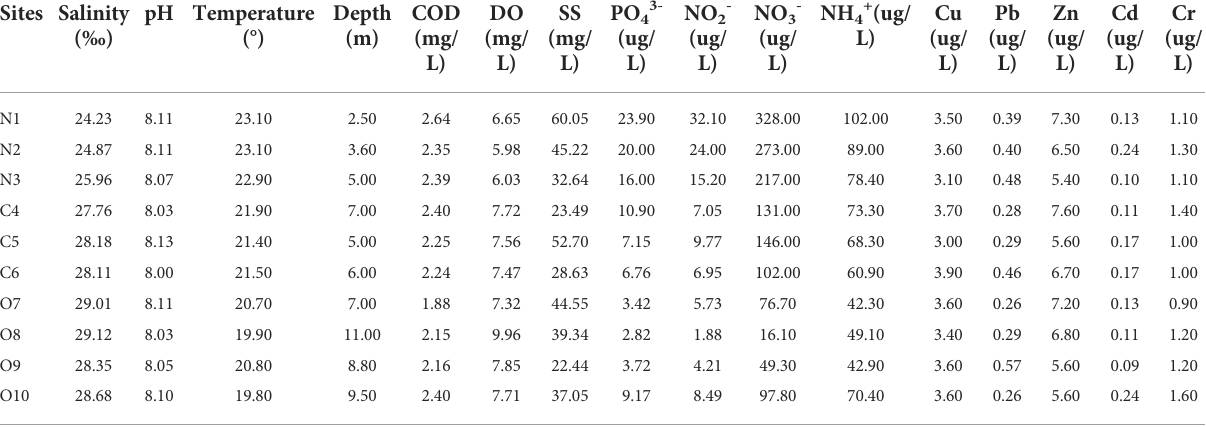
TABLE 1 Physicochemical attributes of the estuary. Sites Salinity ( ‰